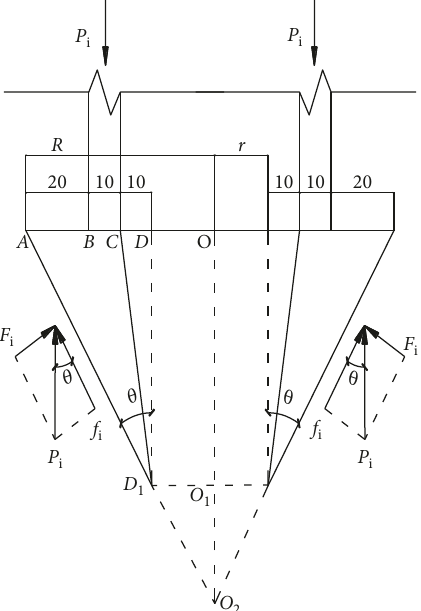
Figure 13: Annular frictionless drill.